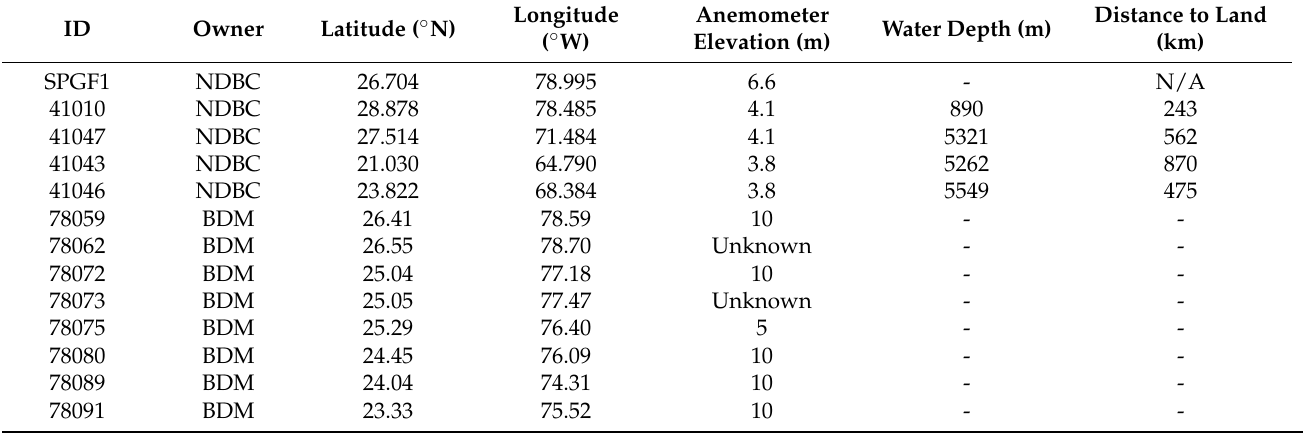
Table 2. Relevant statistics for National Buoy Data Center (NDBC) buoys and the C-MAN station, and operational Bahamas Department of Meteorology (BDM) automatic weather stations. The distance to land is given as the distance between the buoy and the nearest inhabited Bahamian